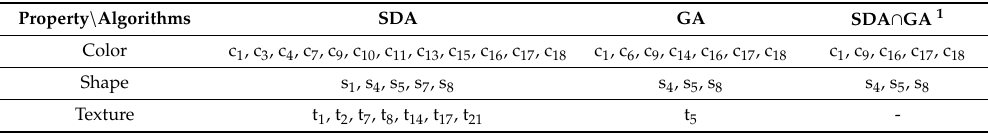
Table 3. Selected features of sweet corn seeds based on stepwise discriminant analysis (SDA) and GA